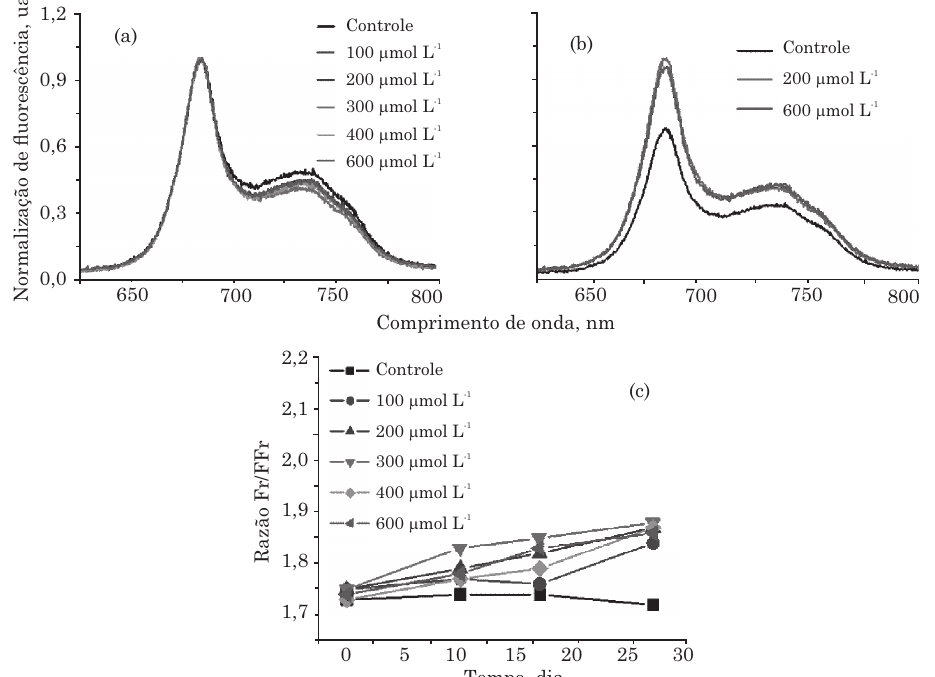
Figura 3. Espectros médios da fluorescência de clorofila em plantas de mamona cultivadas sob doses de Zn em solução nutritiva aos 28 dias, dados normalizados (a) e não normalizados (b), respectivamente. Razão dos espectros de fluorescência de clorofila em função do tempo de cultivo de plantas de mamona, referente às leituras do vermelho e vermelho distante (Fr/FFr) (c).